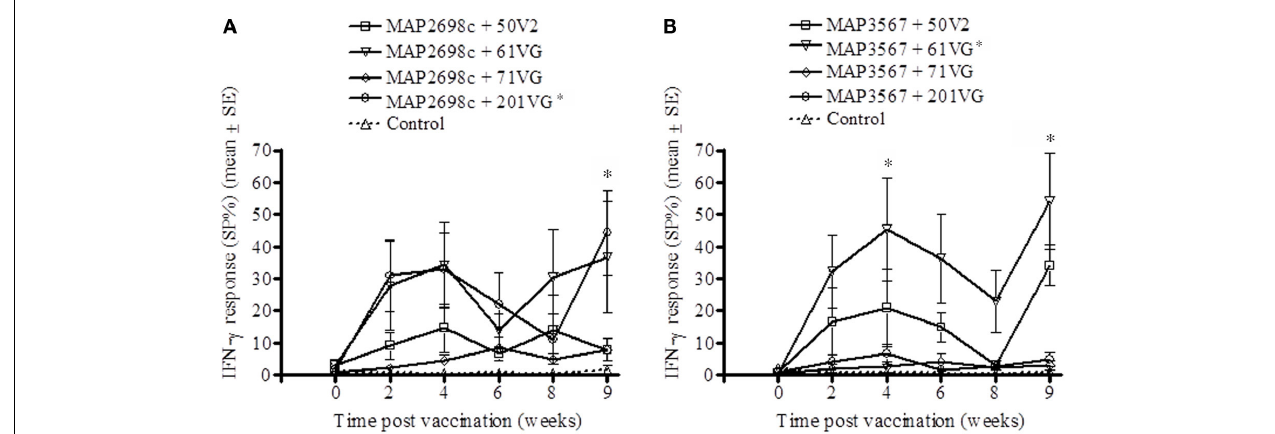
+ adjuvants; (B) MAP3567-specific IFN- γ responses from sheep vaccinated with MAP3567 + adjuvants. Data are mean ± SE . ∗ Significantly higher SP% compared to pre-vaccination ( P < 0 . 05).